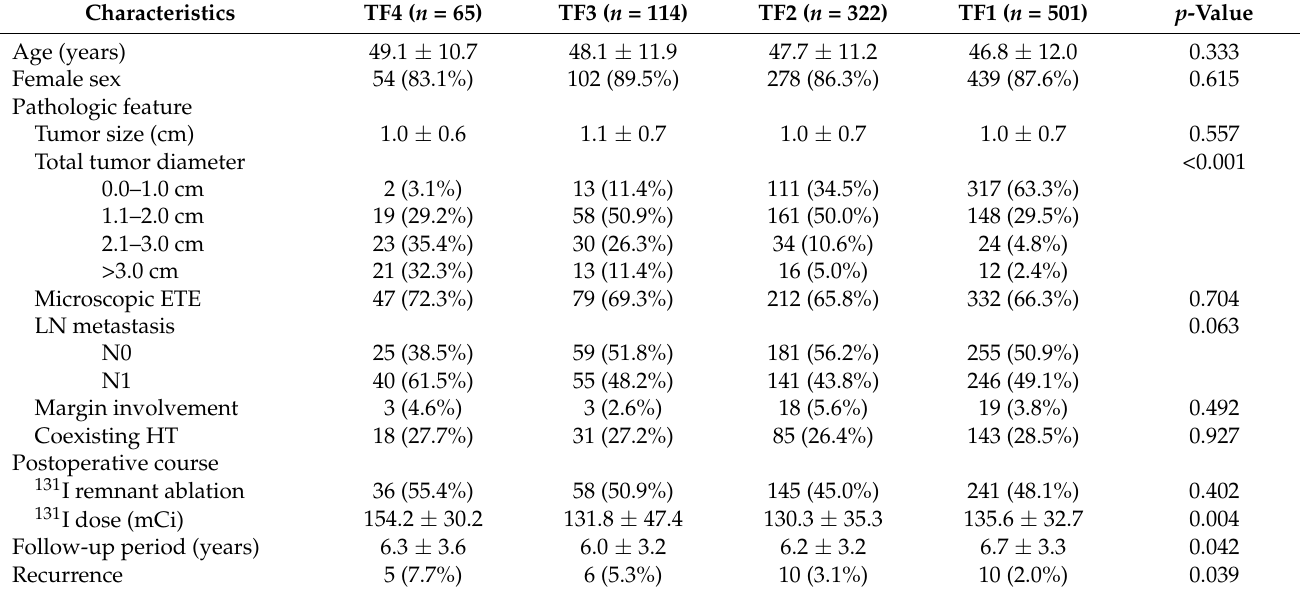
Table 3. Comparison of clinicopathological characteristics among patients with PTC according to the number of tumor foci after propensity score